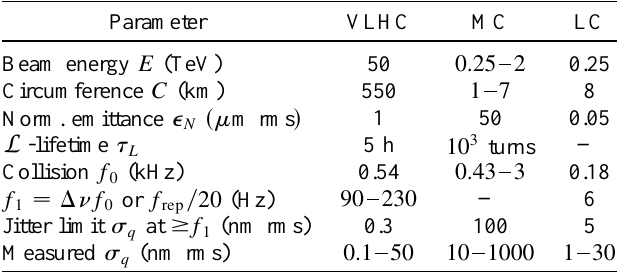
TABLE I. Future colliders: parameters and vibration toler- ances.